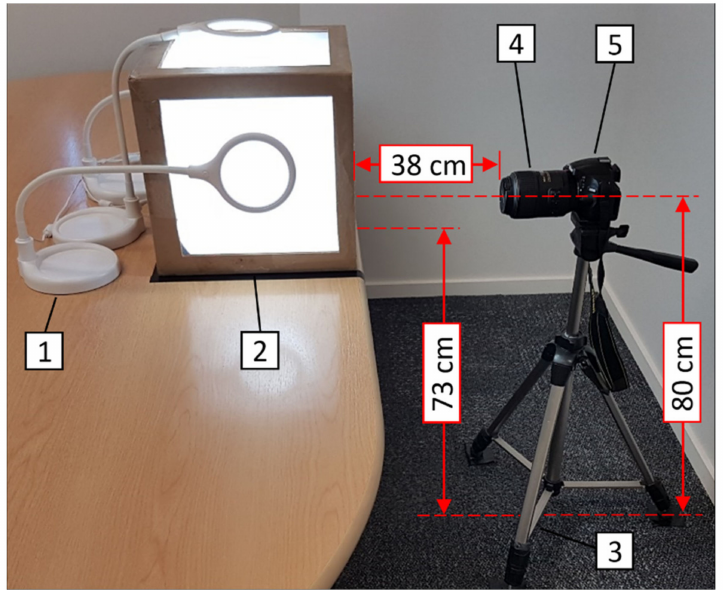
Figure 3. Image acquisition setup comprising (1) three Superlux LSY LED ring lights, (2) self-built light tent, (3) Slik U9000 tripod, (4) Nikon Macro lenses (AF-S Micro Nikkor 105 mm 1:2.8 G), and (5) Nikon D5100 DSLR